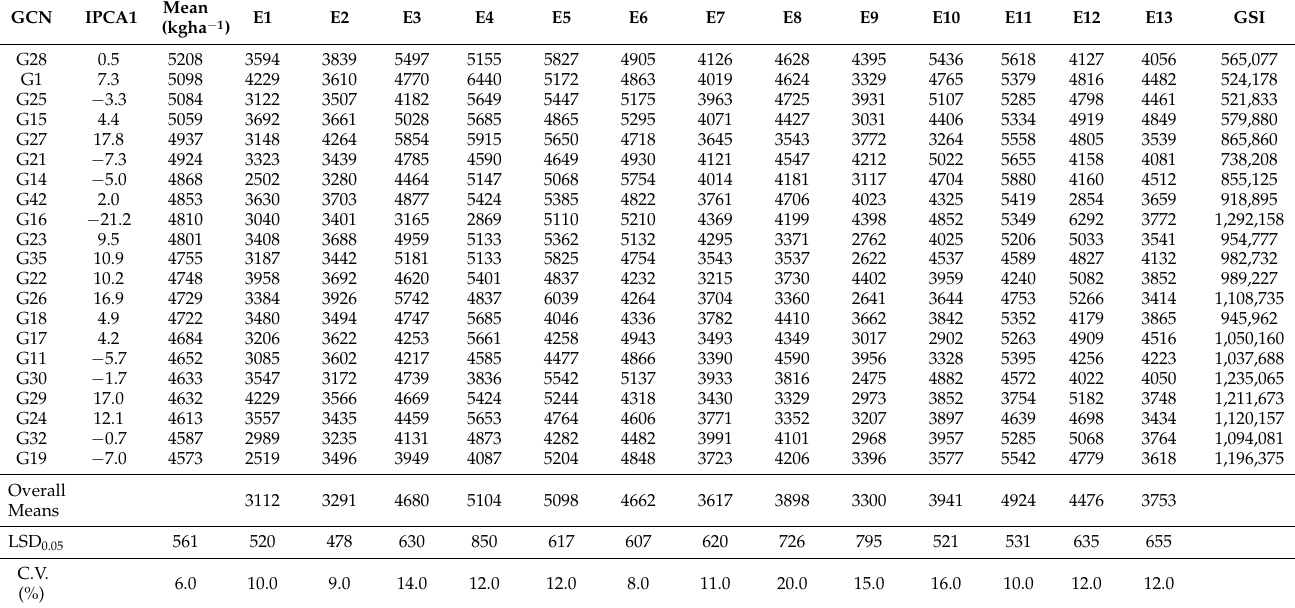
Table 5. AMMI IPCA1 scores and grain yield (kg ha − 1 ) of the top 21 soybean genotypes across 3 countries in southern Africa.